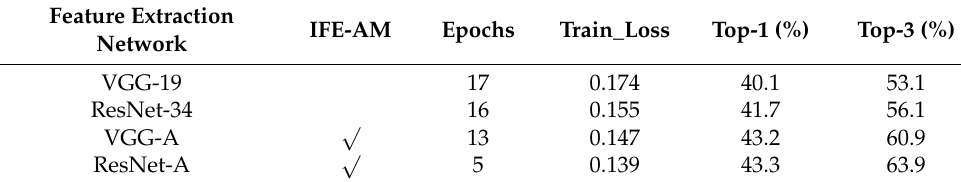
Table 1. Test results.